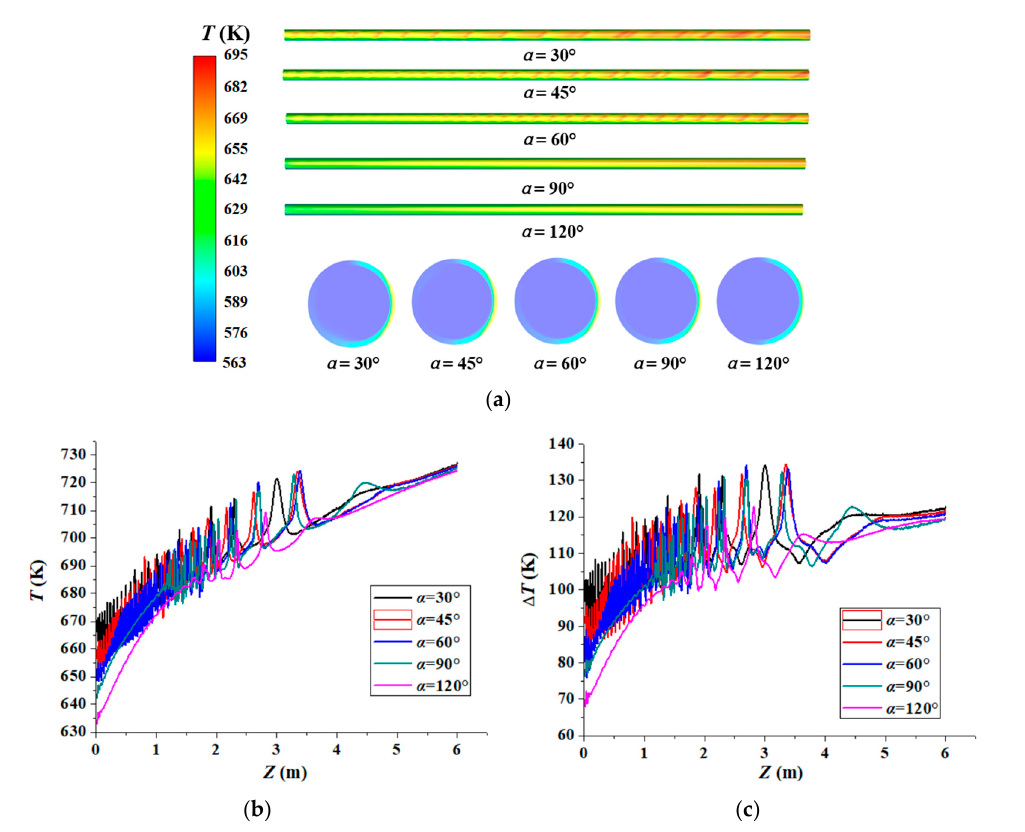
Figure 14. Temperature distributions for different α values: ( a ) temperature contours on S1 and S2; ( b ) temperature distributions on Line 1; ( c ) temperature differences along the tube.